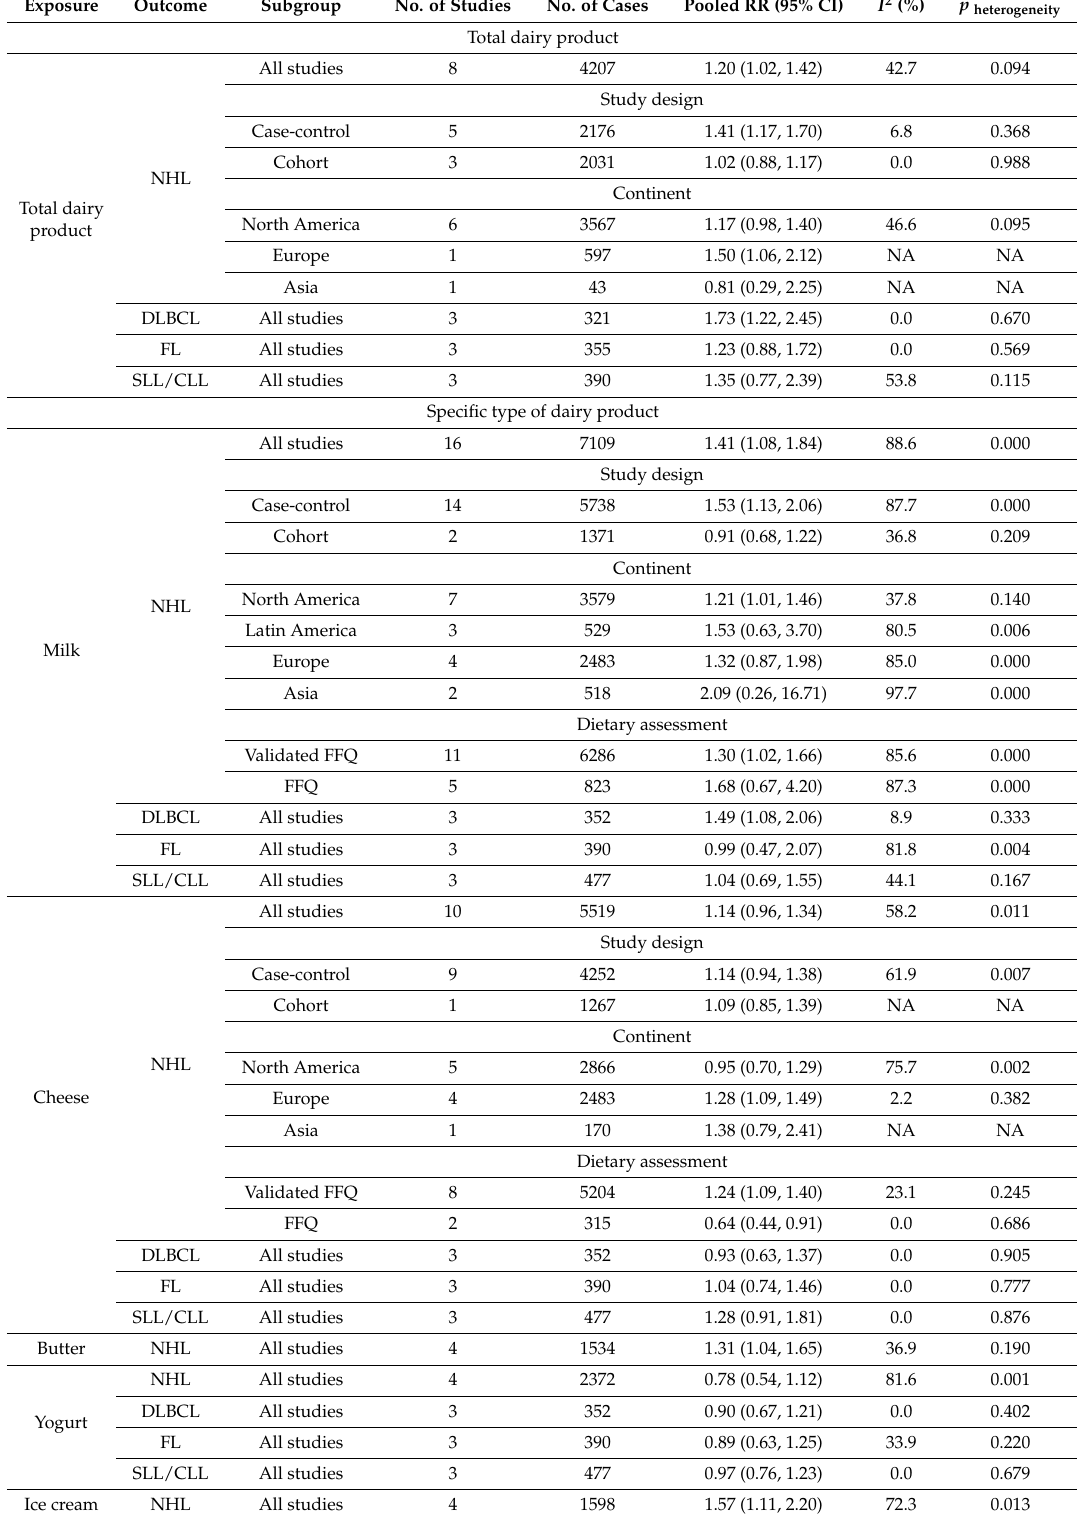
Table 3. Summary risk estimates of the association between dairy product consumption and the risk of NHL and NHL